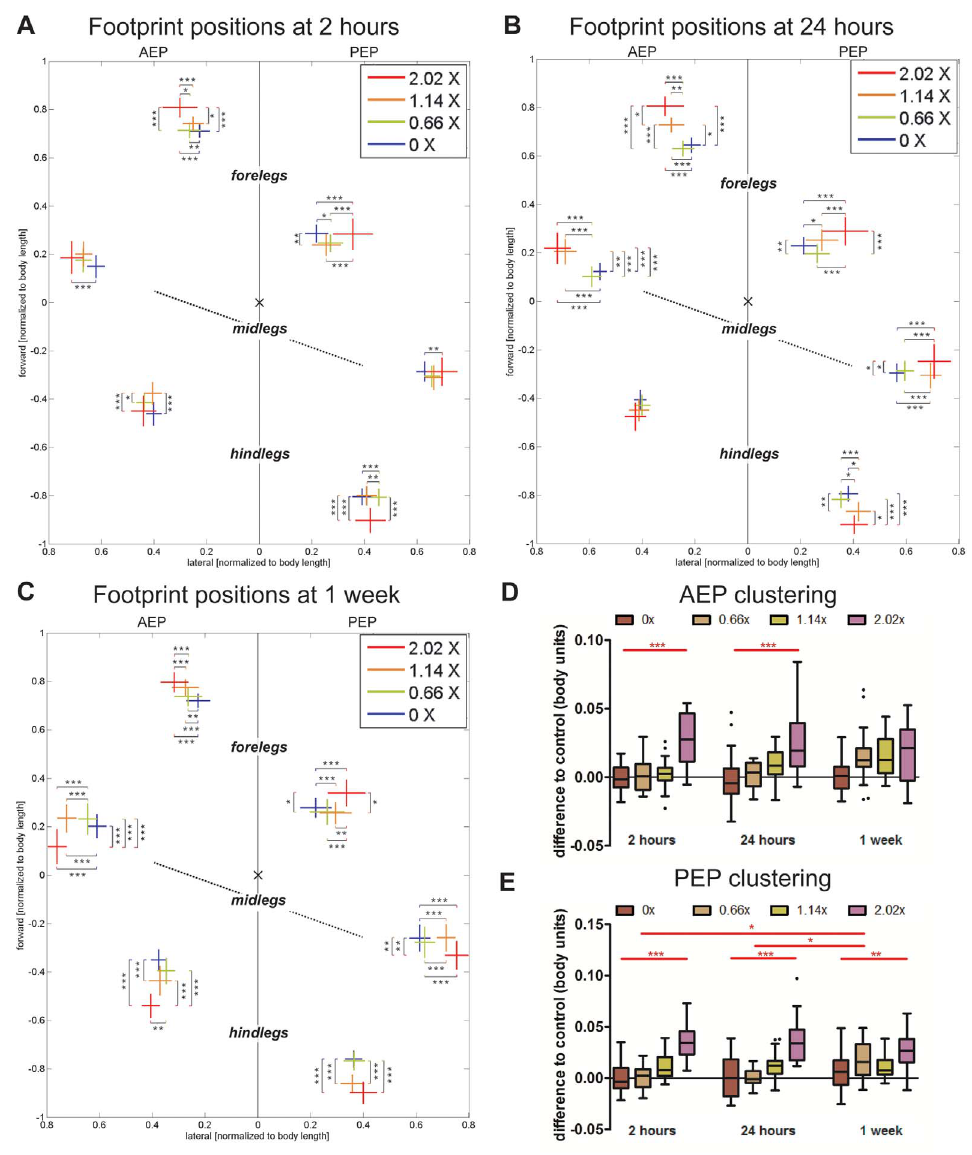
Figure 5. Spatial parameters. (A–C) Footprint positions relative to the body center. AEP and PEP values for each leg are represented on the left and right sections of the plot, respectively. Values are normalized for body size. Line size denotes standard deviations, while intersection indicates mean value. Statistical significance was determined using 2-way-ANOVA with Tukey’s post-hoc tests and post-hoc t-tests, where * p , 0.05; ** p , 0.01; *** p , 0.001. Statistically significant increases are indicated in red. (D–E) AEP and PEP Clustering. Box plots represent the median as the middle line, with the lower and upper edges of the boxes representing the 25% and 75% quartiles, respectively; the whiskers represent the range of the full data set, excluding outliers. Circles indicate outliers. Values show a significant footprint dispersal in 2.02 6 bearing flies compared to